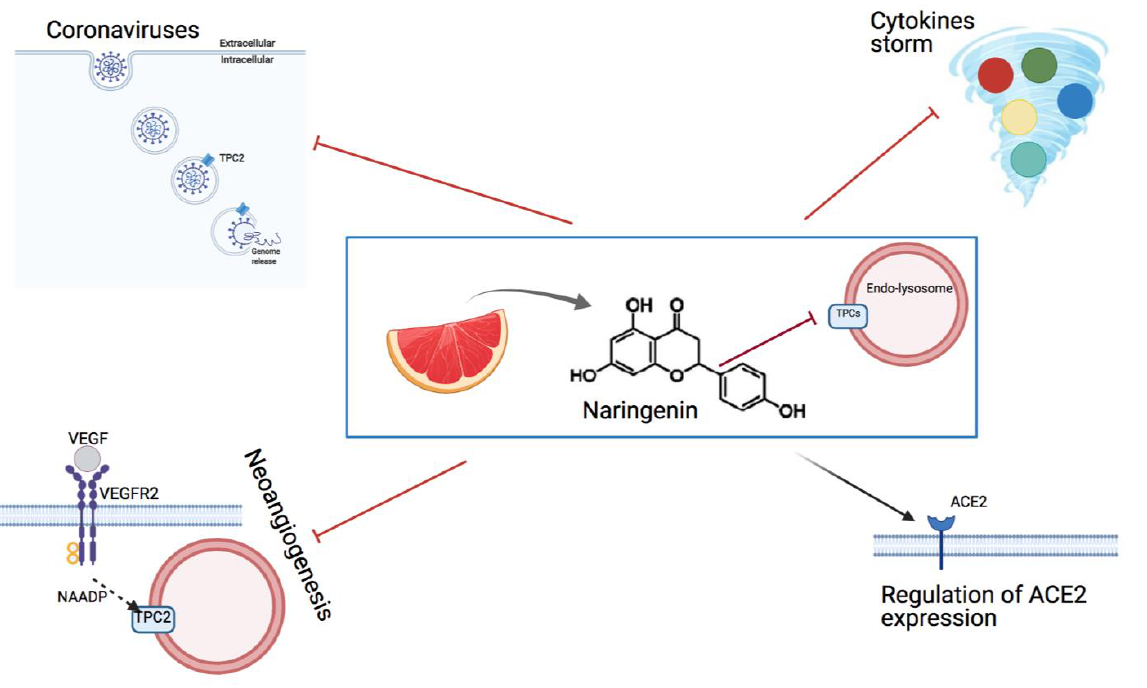
Figure 5. Schematic representation of the possible targets of the flavonoid naringenin, an effective inhibitor of TPCs. Funding: This research received no external funding.